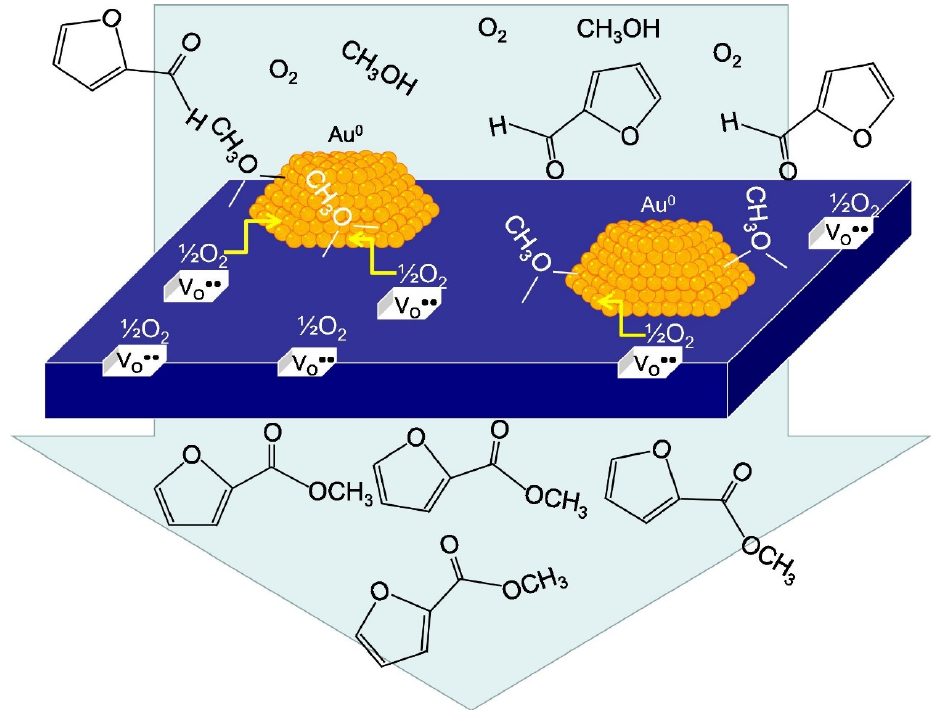
Figure 3. Proposed roles of CeO 2 and Au nanoparticles in the furfural oxidative esterification reaction. Reproduced with permission from [20]. Copyright: Elsevier 2015.